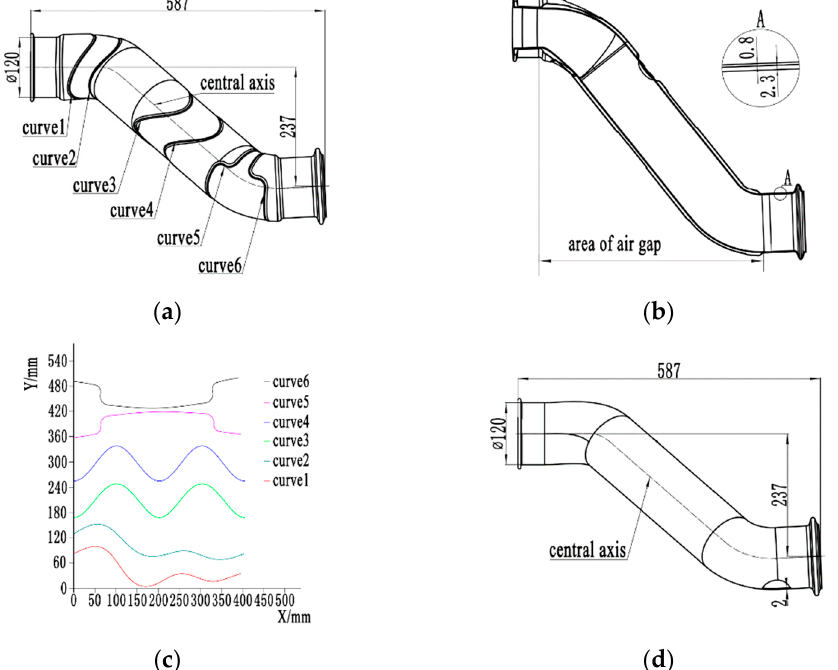
Figure 2. The structure of the front exhaust pipe: ( a ) the overall structure of the double-layered pipe; ( b ) the section of the double-layered pipe; ( c ) the curves of reinforcing ribs in the double-layered pipe; ( d ) the overall structure of the single-layered pipe.